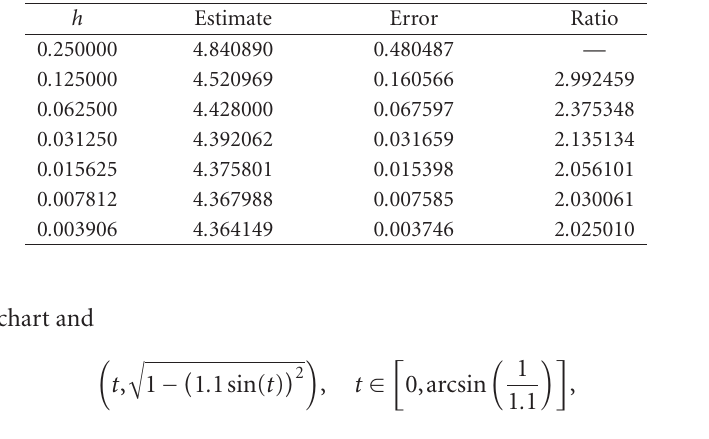
(cid:21) Table 3.1. 1 on Borouchaki and George’s